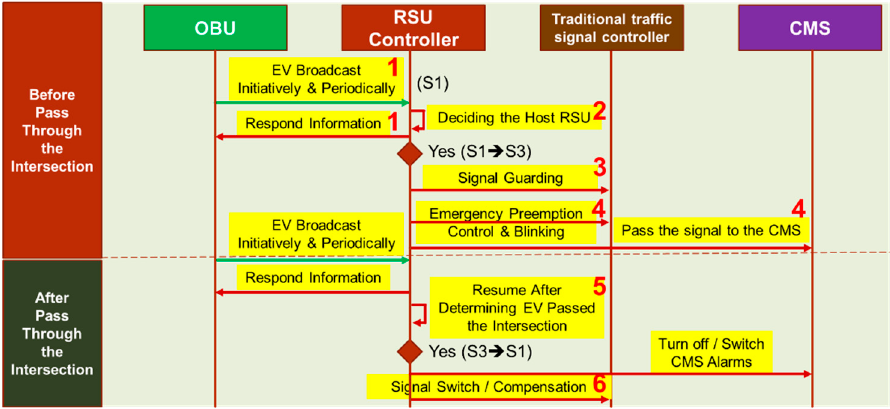
Figure 5. Sequence diagram of the EVSP mode.